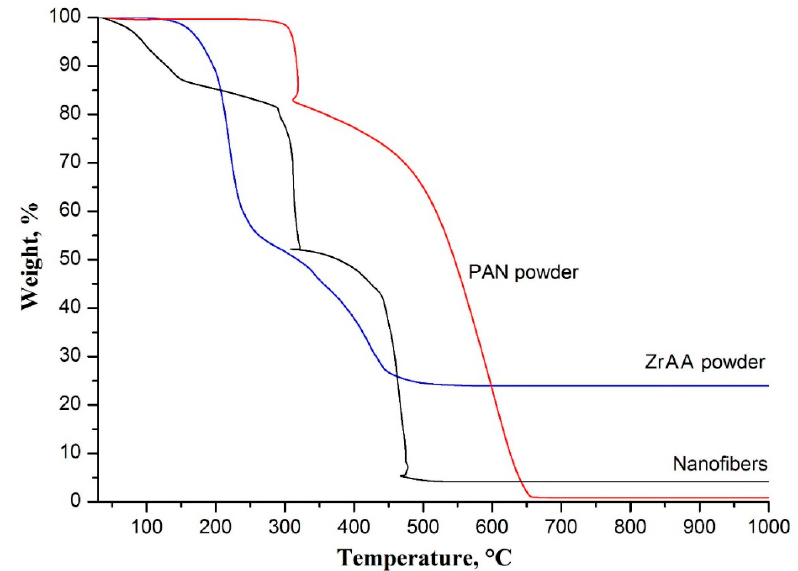
Figure 2. Thermogravimetric (TG) curves of electrospun ZrAA/PAN fibers and powders of initial components.